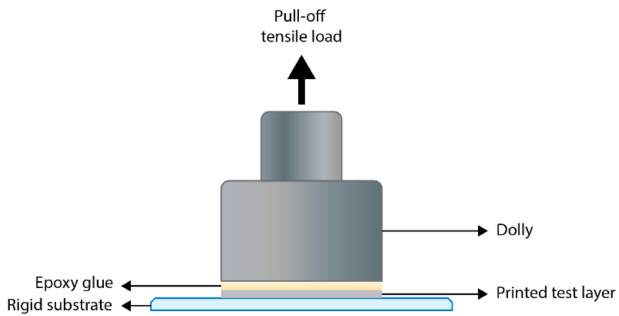
Figure 9. Illustration of the three-step process for visually assessing the cross-cut test.